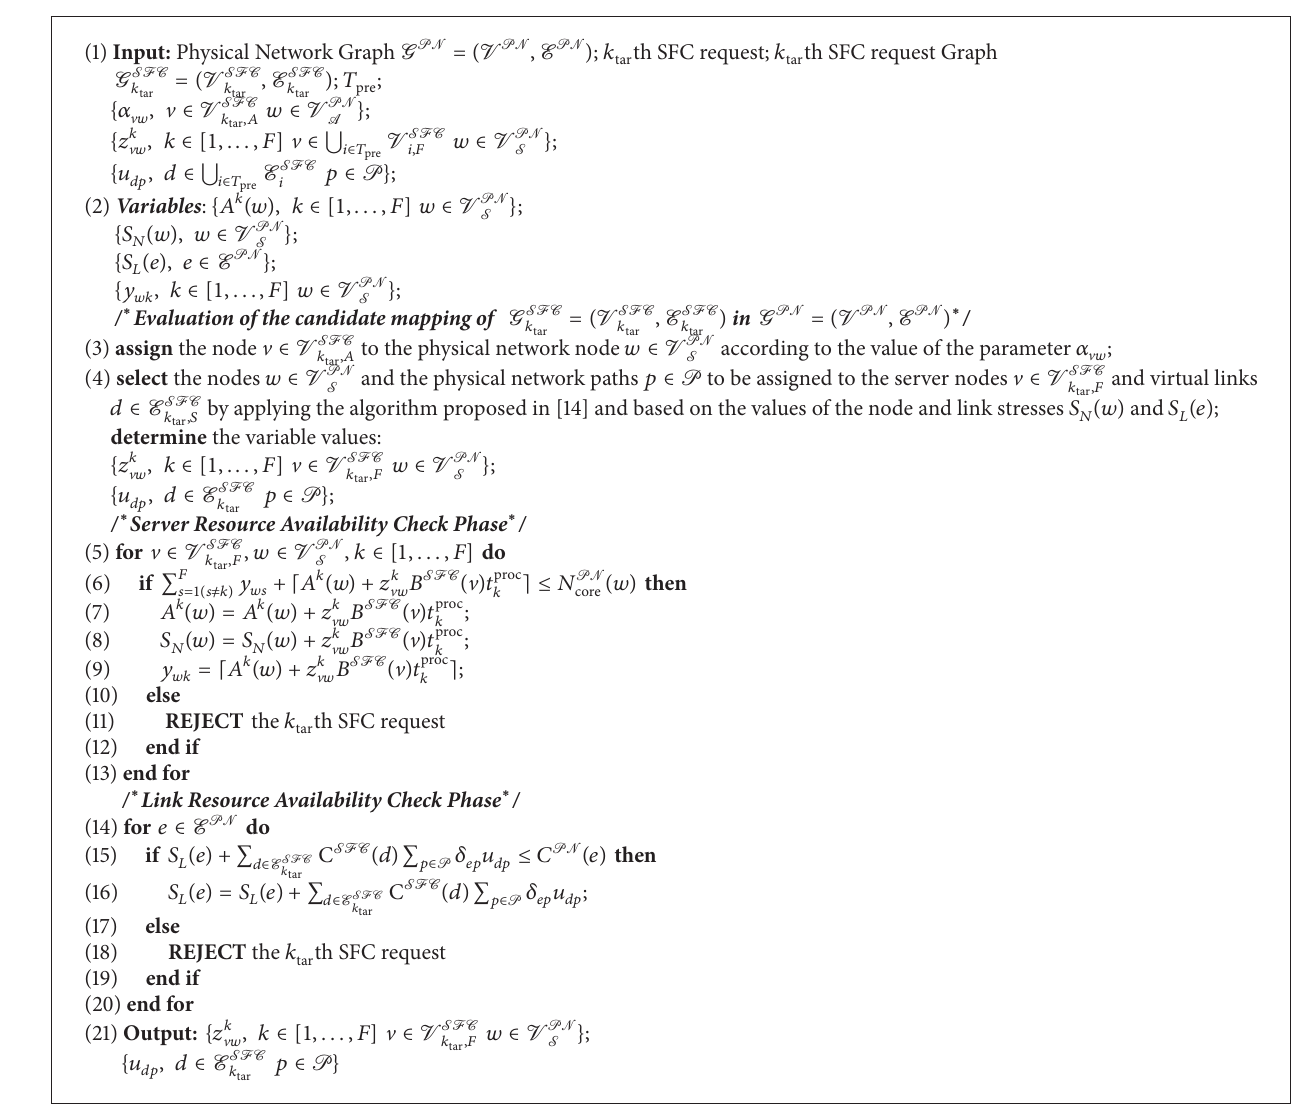
Algorithm 1: MASRN